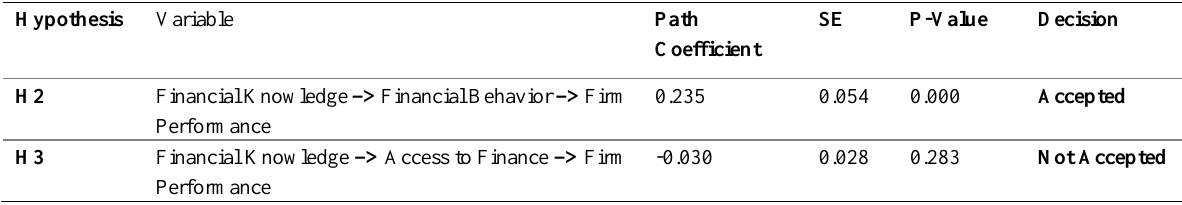
Table 5: Mediation